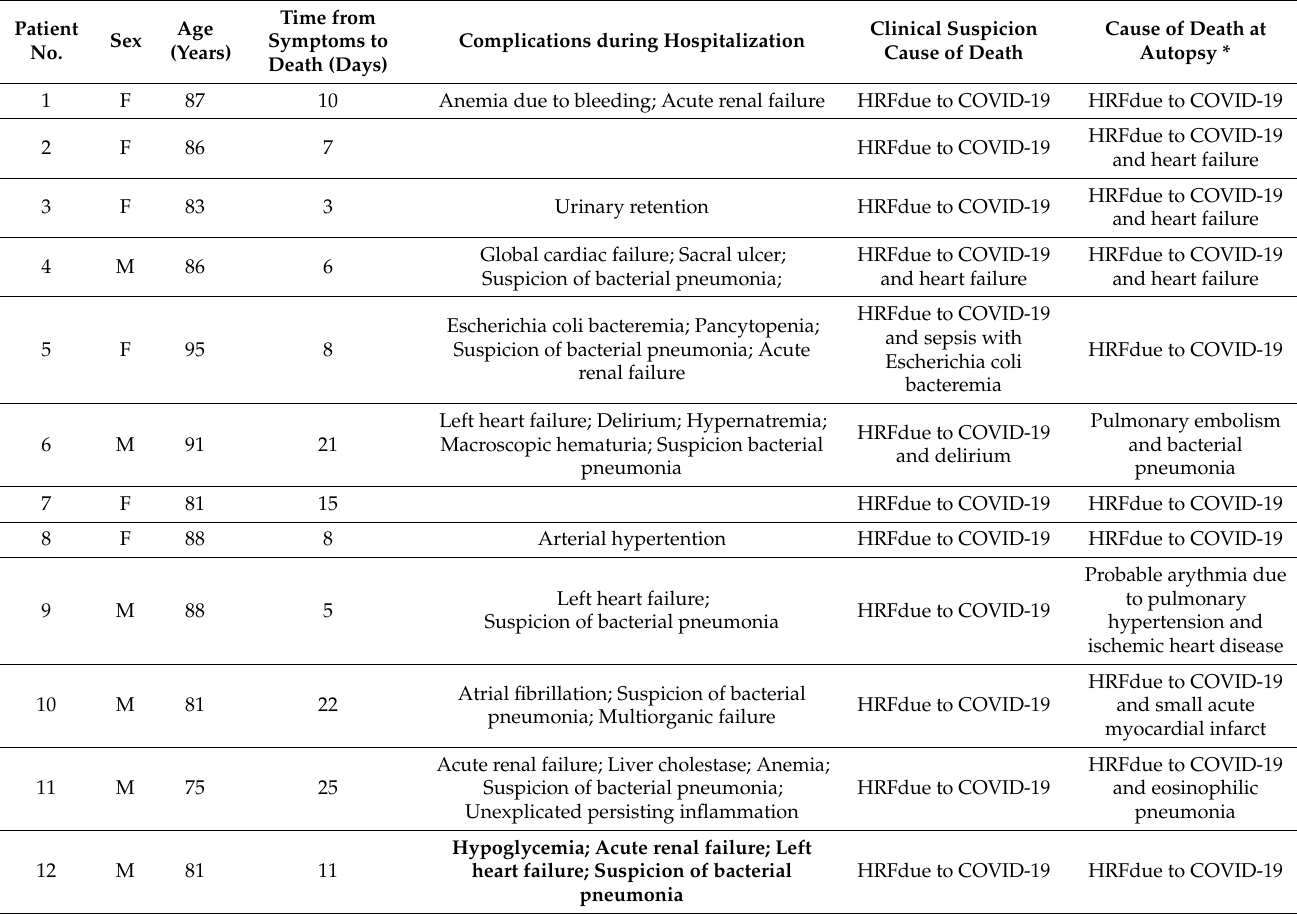
Table 3. Clinical and pathological